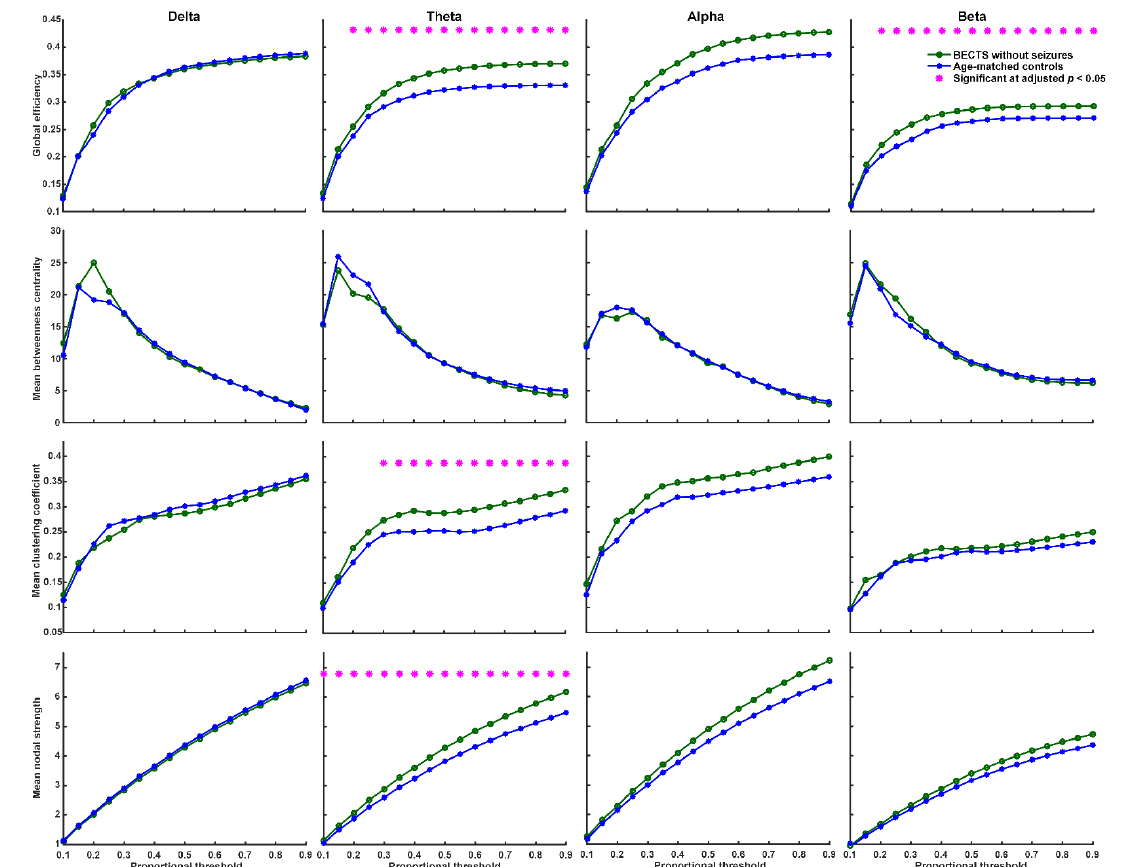
Figure 3. Graph ‐ based functional connectivity indices between BECTS without clinical seizures and age ‐ matched controls as each proportional threshold at each frequency band. Children with BECTS without clinical seizures have significantly higher global efficiency ( ≥ 20% proportional threshold), mean clustering coefficient ( ≥ 30% proportional threshold), and mean nodal strength ( ≥ 10% proportional threshold) in the theta band and higher global efficiency in the beta band at almost all proportional thresholds ( ≥ 20%) compared to age ‐ matched controls (* adjusted p < 0.05).